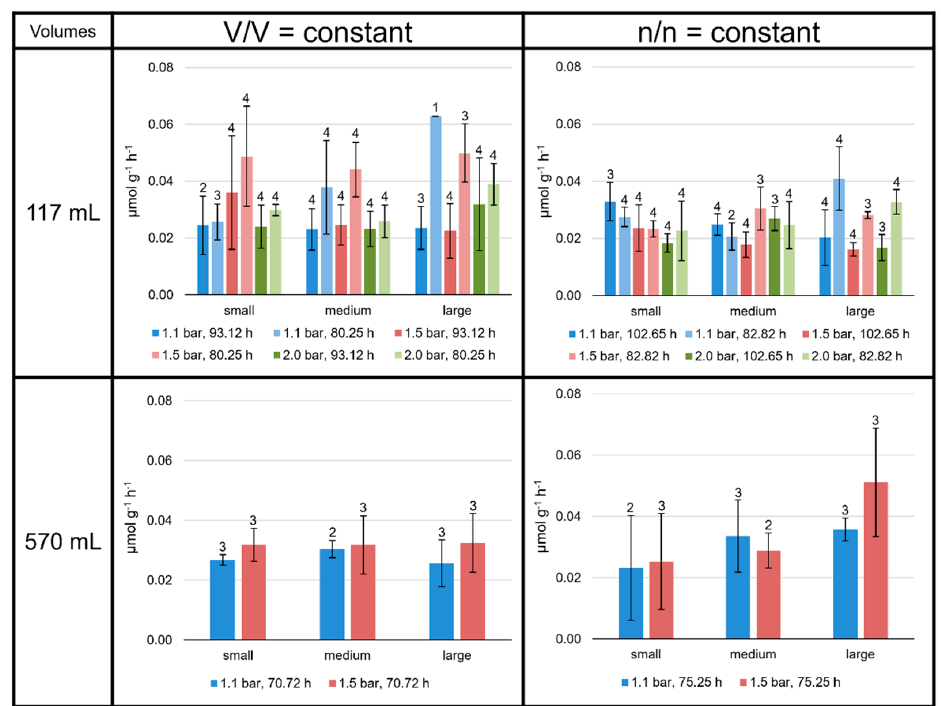
Figure 3. Specific total lipid production rates in M. marburgensis cultures. Pressure is given in bar relative to atmospheric pressure. Production rates are given in μ mol g − 1 h − 1 . Errors are standard deviations. Numbers above bars indicate number of samples. Samples quantified with 5- α -cholestane standard are indicated in Tables S4–S9.